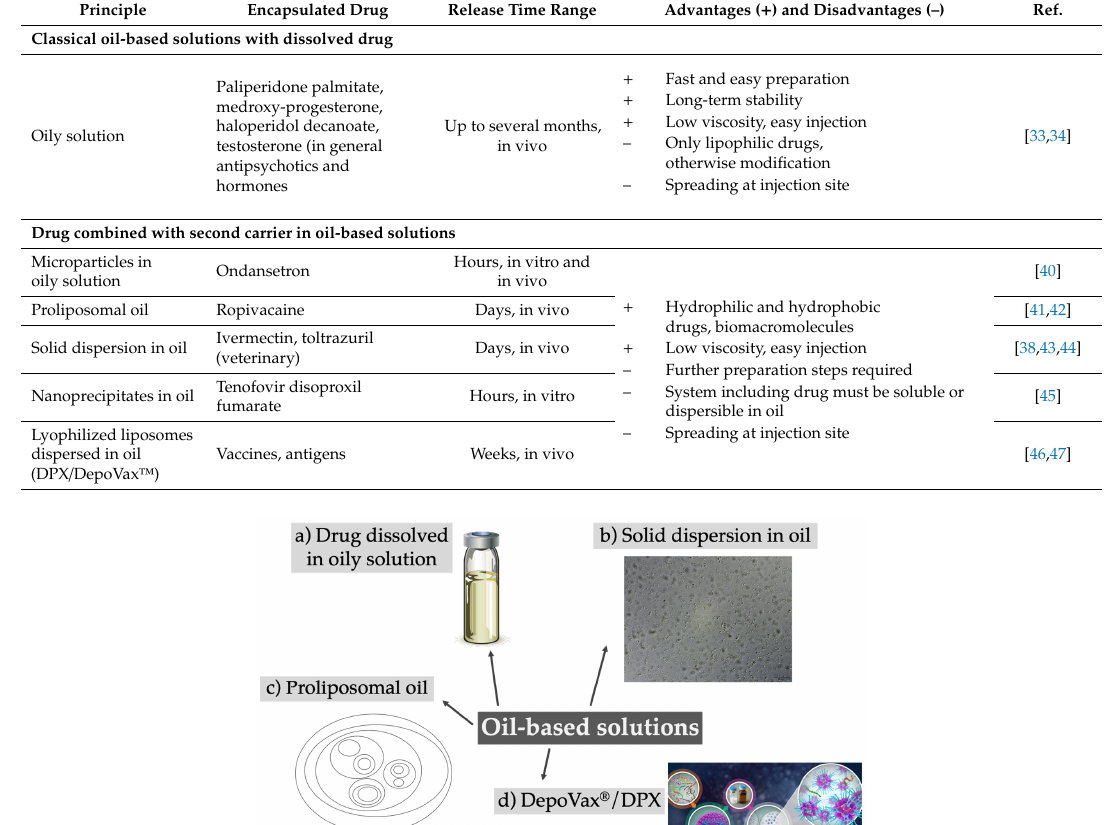
Table 2. Overview of oil-based drug delivery systems.